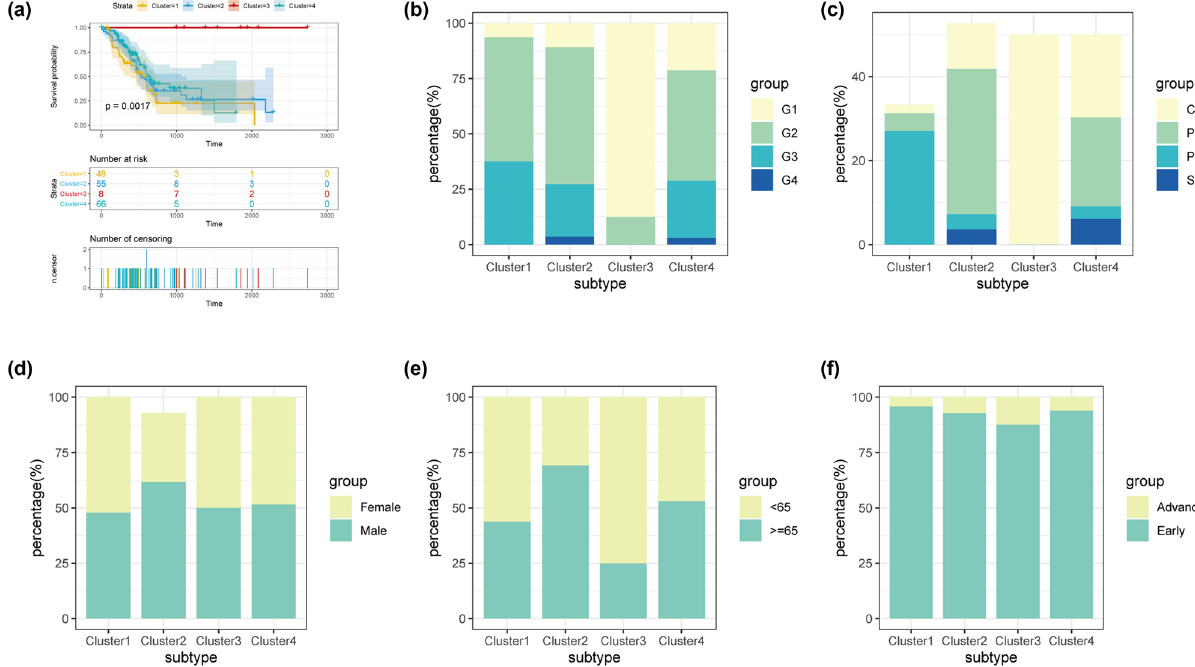
Figure 3: Prognostic analysis and clinical phenotype of the subgroup: ( a ) Kaplan – Meier survival analysis; ( b ) the distribution of WHO classi fi - cations in di ff erent subgroups; ( c – f ) distribution of chemotherapy response ( c ) , gender ( d ) , age ( e ) , and tumor stage ( f ) in the four